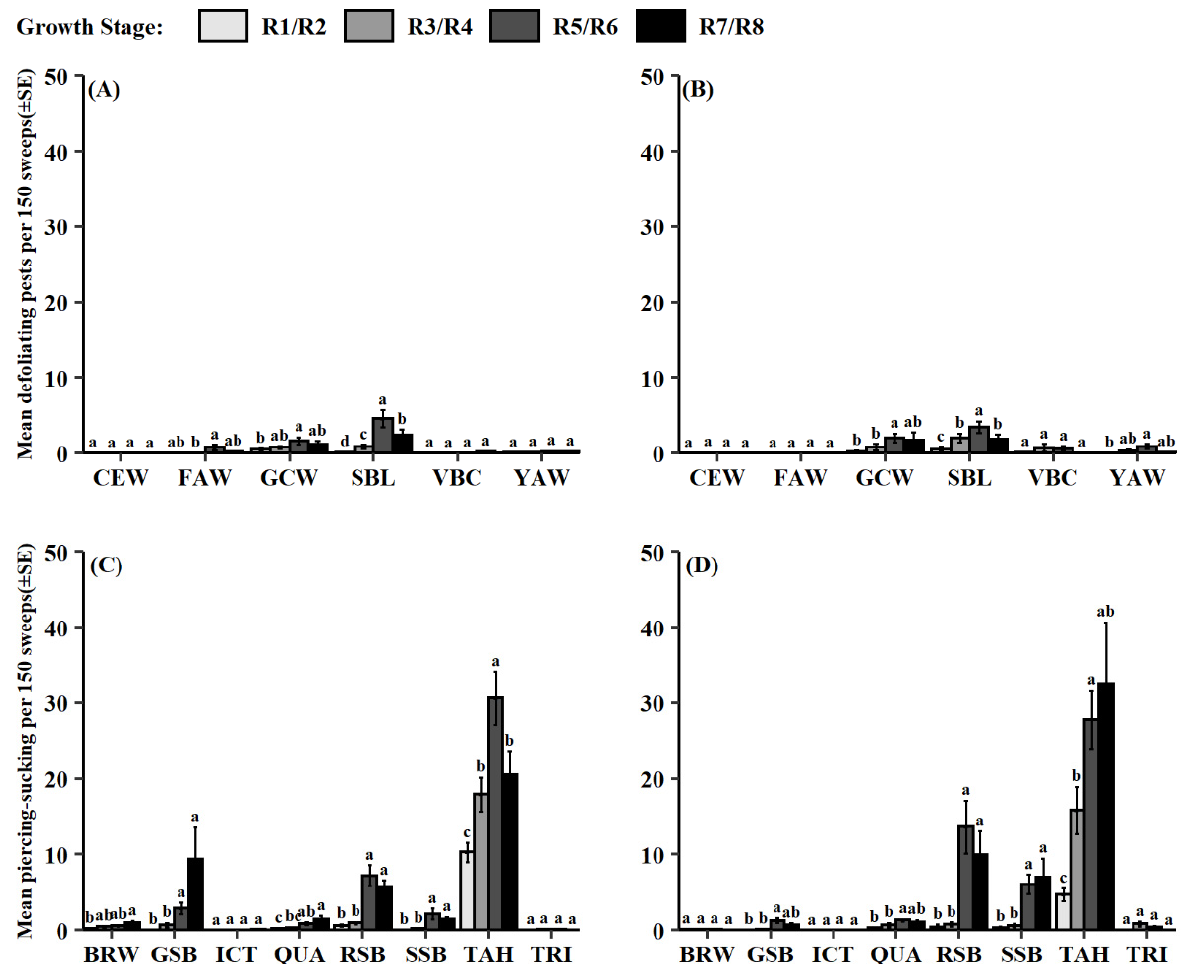
Figure 3 . Mean pest count per 150 sweeps (±SE) for collected defoliating pest groups across soybean growth stages in datasets ( A ) 2012–2014 and ( B ) 2015–2018; piercing-sucking pest groups in datasets ( C ) 2012–2014 and ( D ) 2015–2018. Same letter denotes no significant difference between means ( p > 0.05). Abbreviations for defoliating pest groups: CEW = H. zea , FAW = S. frugiperda , GCW = H. scabra , SBL = C. includens , VBC= A. gemmatalis , YAW = S. ornithogalli ; piercing-sucking pests: BRW = E. servus , GSB = C. hilaris , ICT = E. ictericus , QUA = E. quadrator , RSB = P. guildinii , SSB = N. viridula , TAH = S. festinus , TRI = E. tristigmus . For both datasets, soybean MG had a significant effect on piercing-sucking pests, but not defoliating pests (defoliating pests: 2012–2014, F = 1.72, df = 2, 984, p = 0.180; 2015–2018, F = 0.70, df = 2, 330, p = 0.496; piercing-sucking pests: 2012–2014, F = 6.45, df = 2, 1312, p < 0.002; 2015–2018, F = 5.04, df = 2, 440, p < 0.007). From 2012 to 2014, significantly more piercing-sucking pests were found in MG V compared to MG III, but MG V was not significantly more than MG IV (Figure S2A). From 2015 to 2018, MG IV had significantly more piercing-sucking pests collected compared to MG III, but not MG V (Figure S2B).